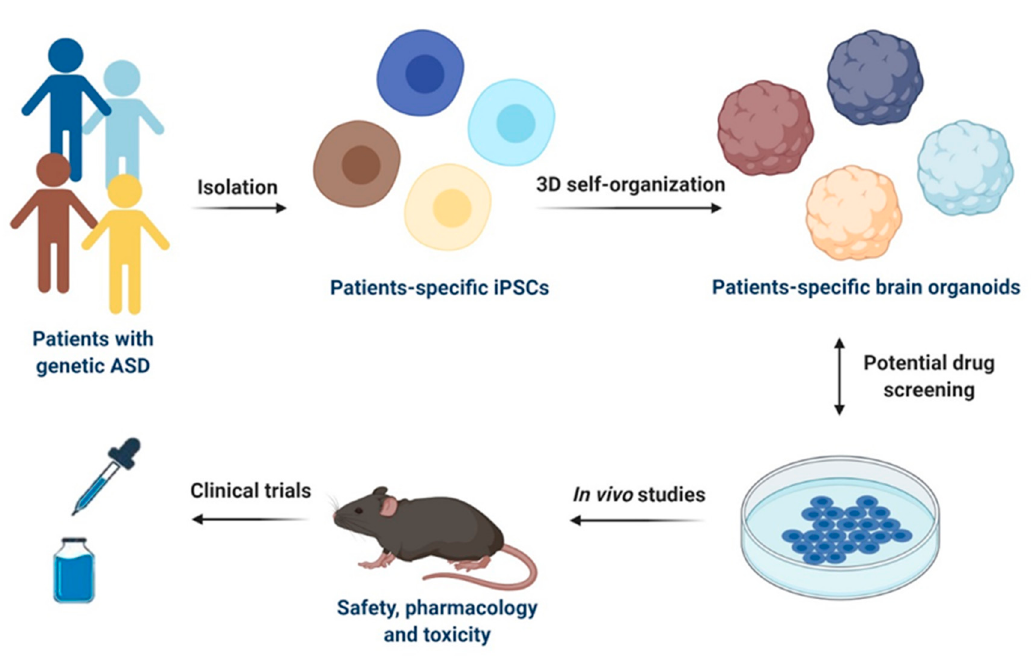
Figure 2. Schematic representation of iPSCs-based models for drug discovery and development in ASD. Specific iPSCs can be isolated from patients with genetic ASD and can be further differentiated into patients-specific iPSCs or 3D self- organized in brain organoids. Potential drug screening can be performed in both 2D cultures of iPSCs-derived cells types of the CNS and in brain organoids. Selected drug candidates can be then firstly tested in in vivo models for safety, pharmacology, and toxicity and then used for clinical trials in humans. This figure was created with BioRender.com (accessed on 11 February 2021).